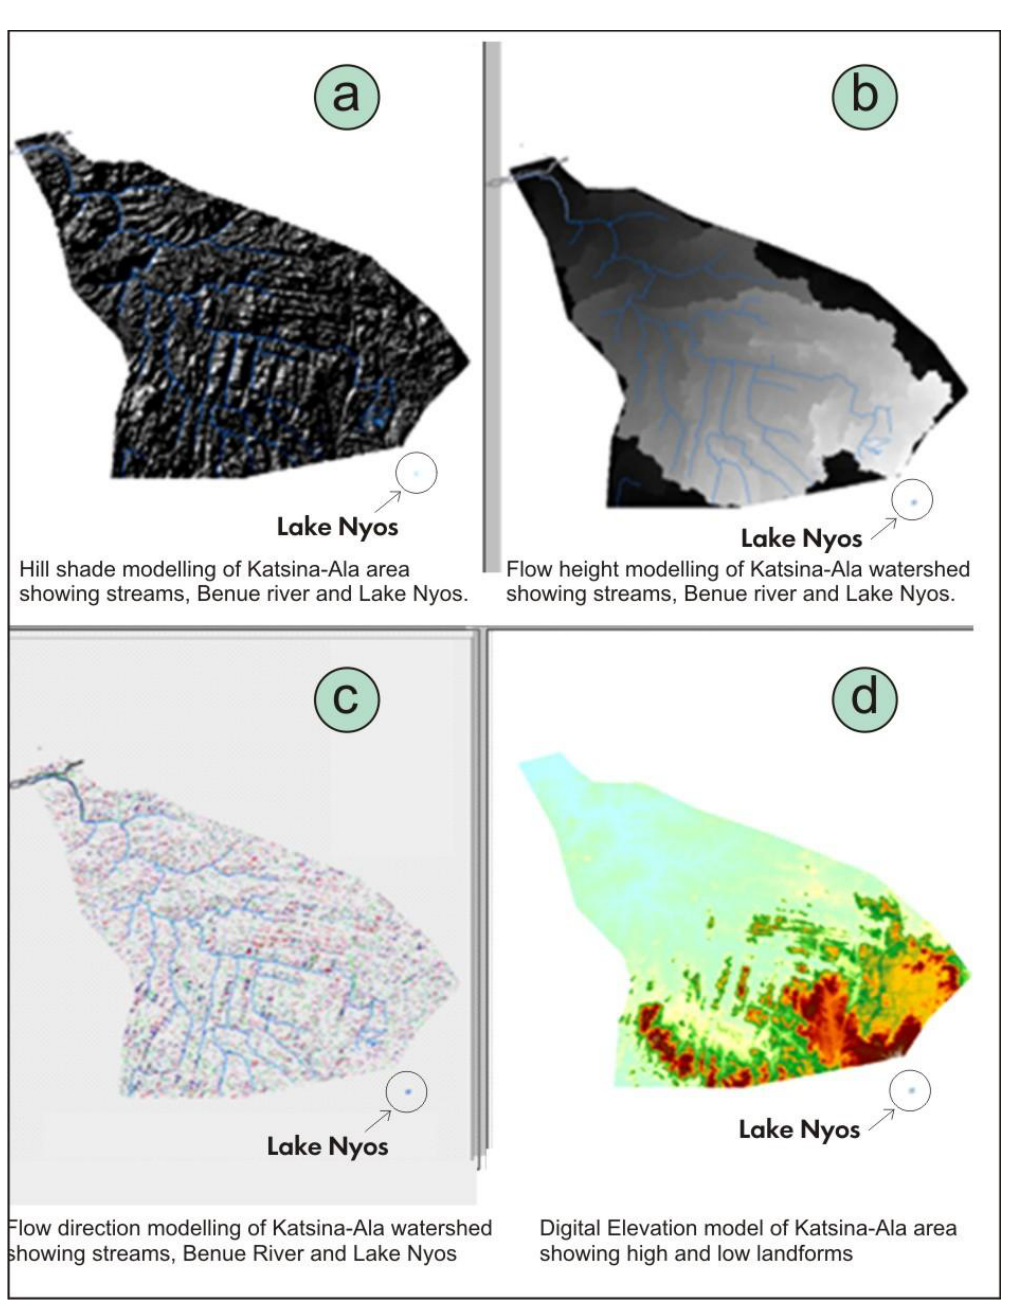
Figure 2: Digital elevation models showing the fracture and drainage patterns, altitude and land use/cover type in Katsina-Ala drainage